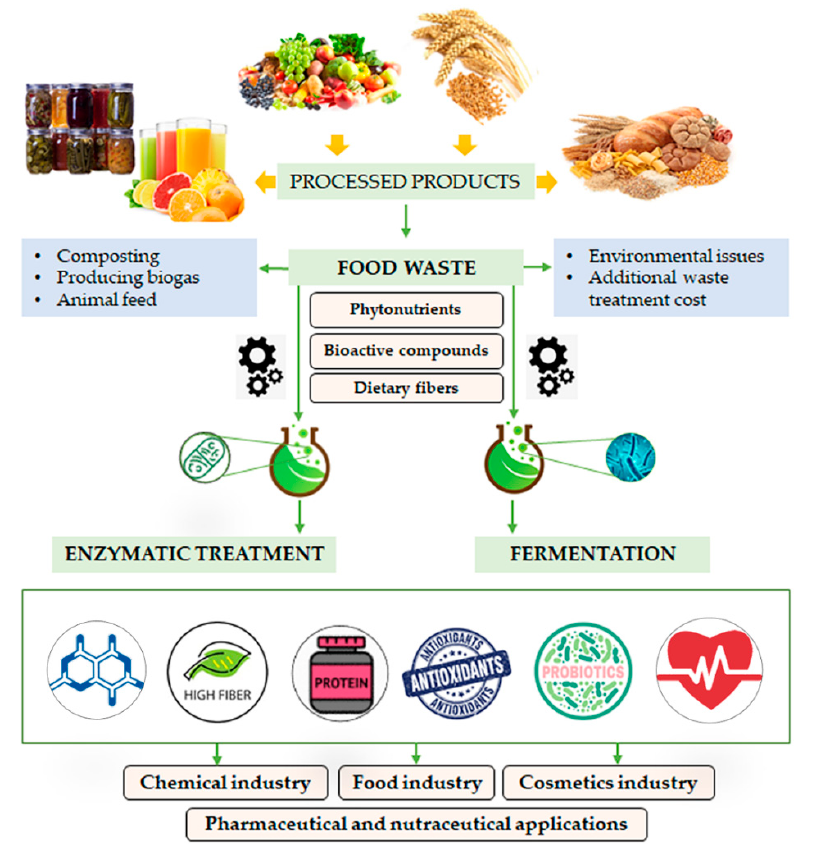
Figure 2. Graphical illustration of the fate of fruit, vegetable and cereal wastes after enzymatic treatment and fermentation.